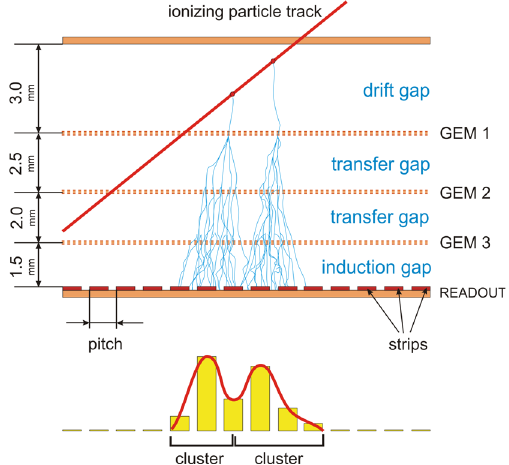
Figure 2. BM@N triple-GEM structure and signal formation